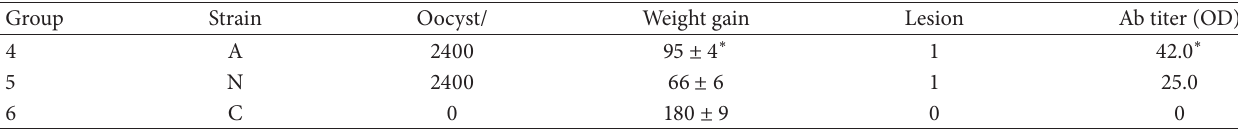
Figure 1: Normal oocysts of Eimeria tenella during in vitro growth and sporulation from 0 to 38 h (slide representative from over 100 organisms). (a) Immature organism (unsporulated oocyst) at 0h × 1,000. (b) Normal organism start division at 16h × 1,200. (c) Four spherical sporoblasts and a polar granule formation visible at 20 h × 1,100. (d) Ellipsoidal sporoblasts at 24h × 1,000. (e) Sporocysts formation at 28 h × 1,000. (f) Sporocysts formation completed, each containing 2 mature sporozoites at 38 h × 1,000. Table 2: Six White Leghorn birds/group were immunized with 240 followed by 2400 normal (N) or altered (A) oocysts of E. tenella with a two-week interval (week 3). Control (C) birds that received sham inoculation (0) gained most but with no titers. Body weight gain/g and sera antibody titer production in group A versus group N showed significant difference; ∗ 𝑝 < 0.05